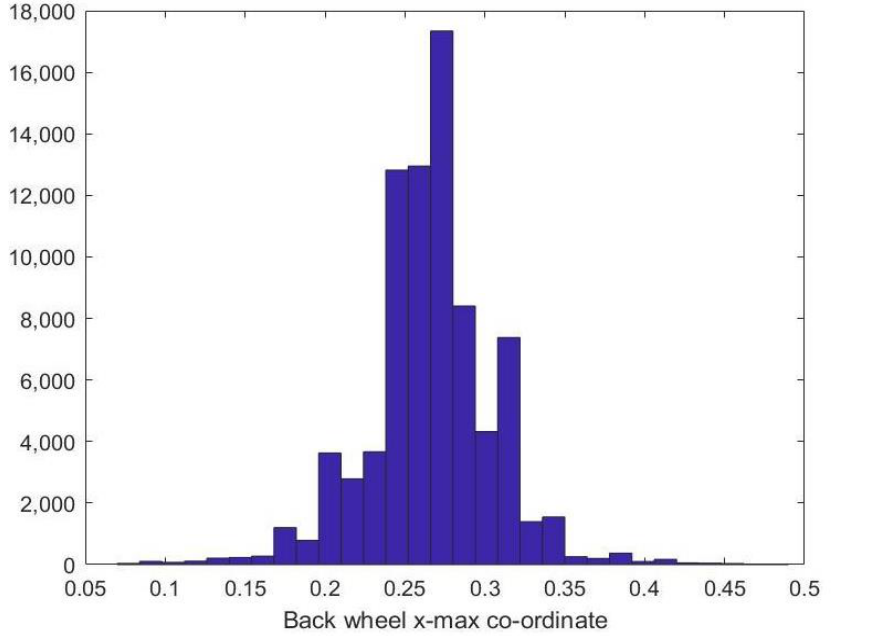
Figure 7. Back-wheel x-max co-ordinate histogram.